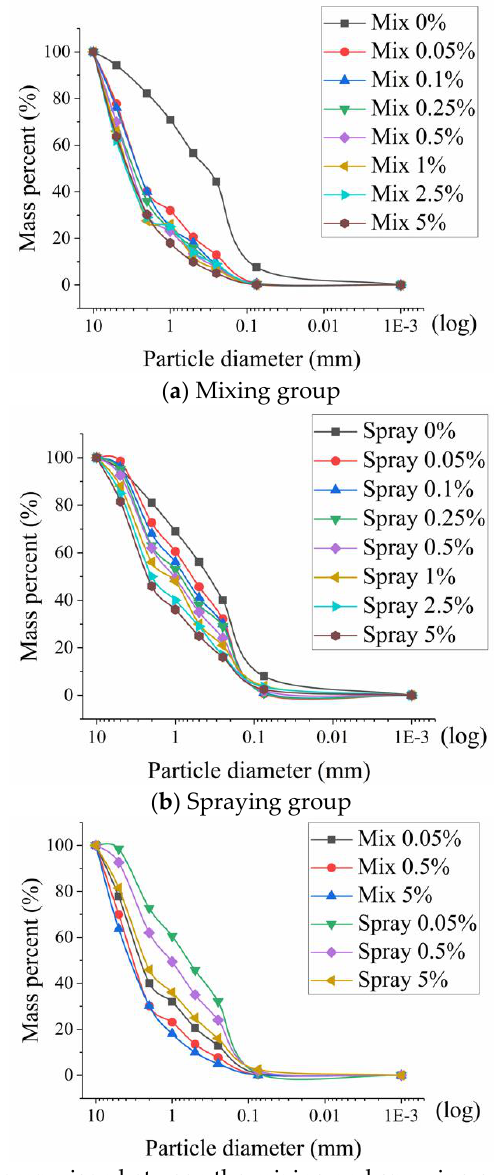
Figure 3. Particle grading curves.